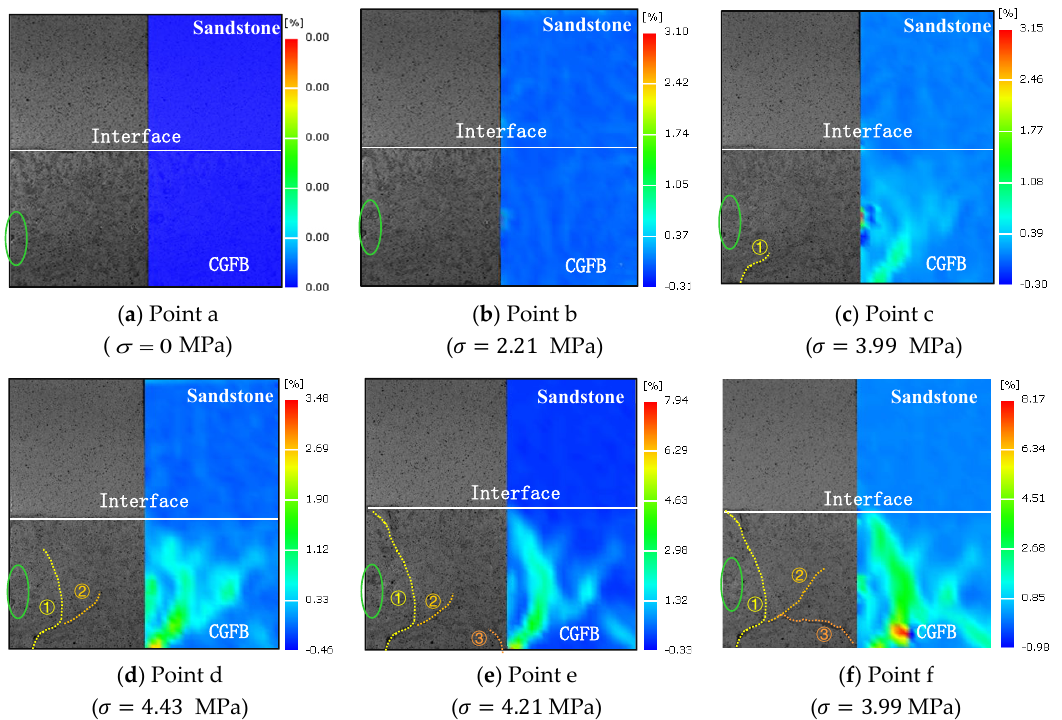
Figure 8. Evolution characteristics of the maximum principal strain field of the sandstone–CGFB mass under uniaxial loading: ( a ) point of the reference image selected with the digital scatter correlation method and ( b – f ) points of the deformation image selected with the digital scatter correlation method. The green circles show the initial damage area; the dotted lines indicate the nascent crack; and σ is the axial stress corresponding to the characteristic point.